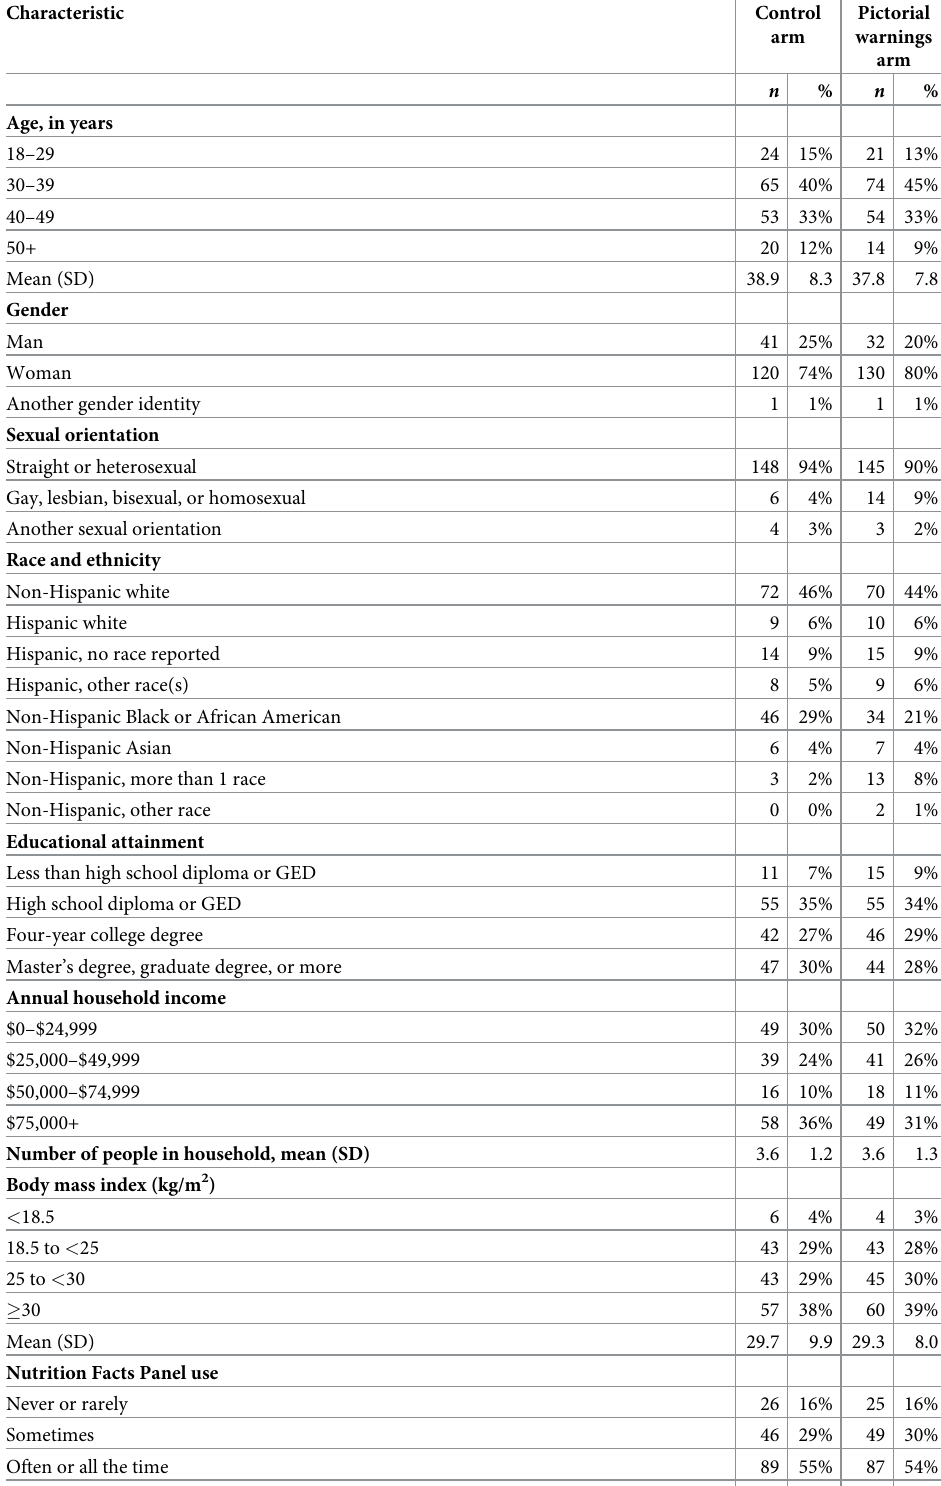
Table 1. Participant characteristics ( n =